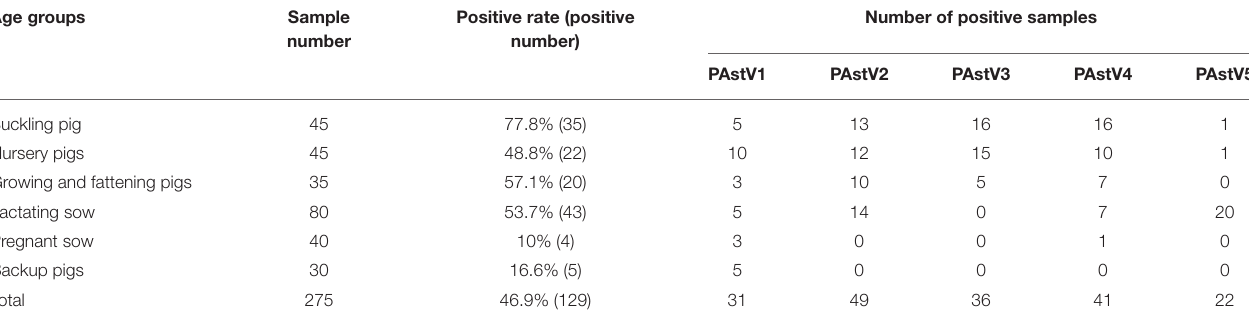
TABLE 3 | Results of field samples detected by the multiplex